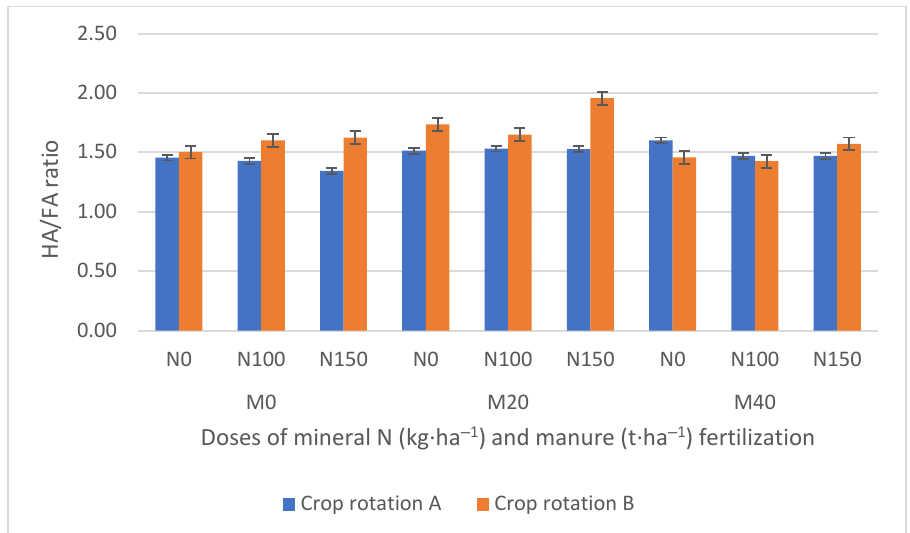
Figure 7. The HA/FA ratio contents in in the topsoil layer (0–30 cm) as influenced by crop rotation (I), manure application (II) and inorganic N rate (III) in the long-term field experiment at Grabow, Poland. Error bars denote standard deviations ( n = 3). LSD ( p ≤ 0.05): for I = 0.051, II = 0.047, III = n.s., II/I = 0.067, I/II = 0.073,III/I = 0.055, I/III = 0.065, III/II = n.s., II/III = n.s.